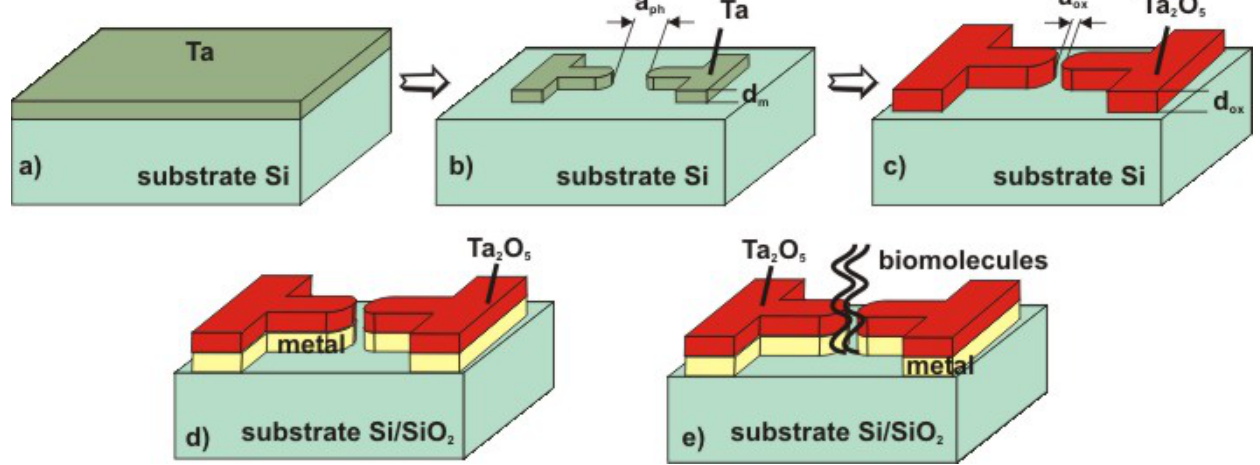
Figure 1. Schematic of the technological process steps for the fabrication of nanostructures: a) deposition of the metallic layer (Ta); b) patterning of the metallic layer with a pattern-size resolution (a ) of photolithography; c) conversion of the metallic pattern to a metal-oxide layer by ph